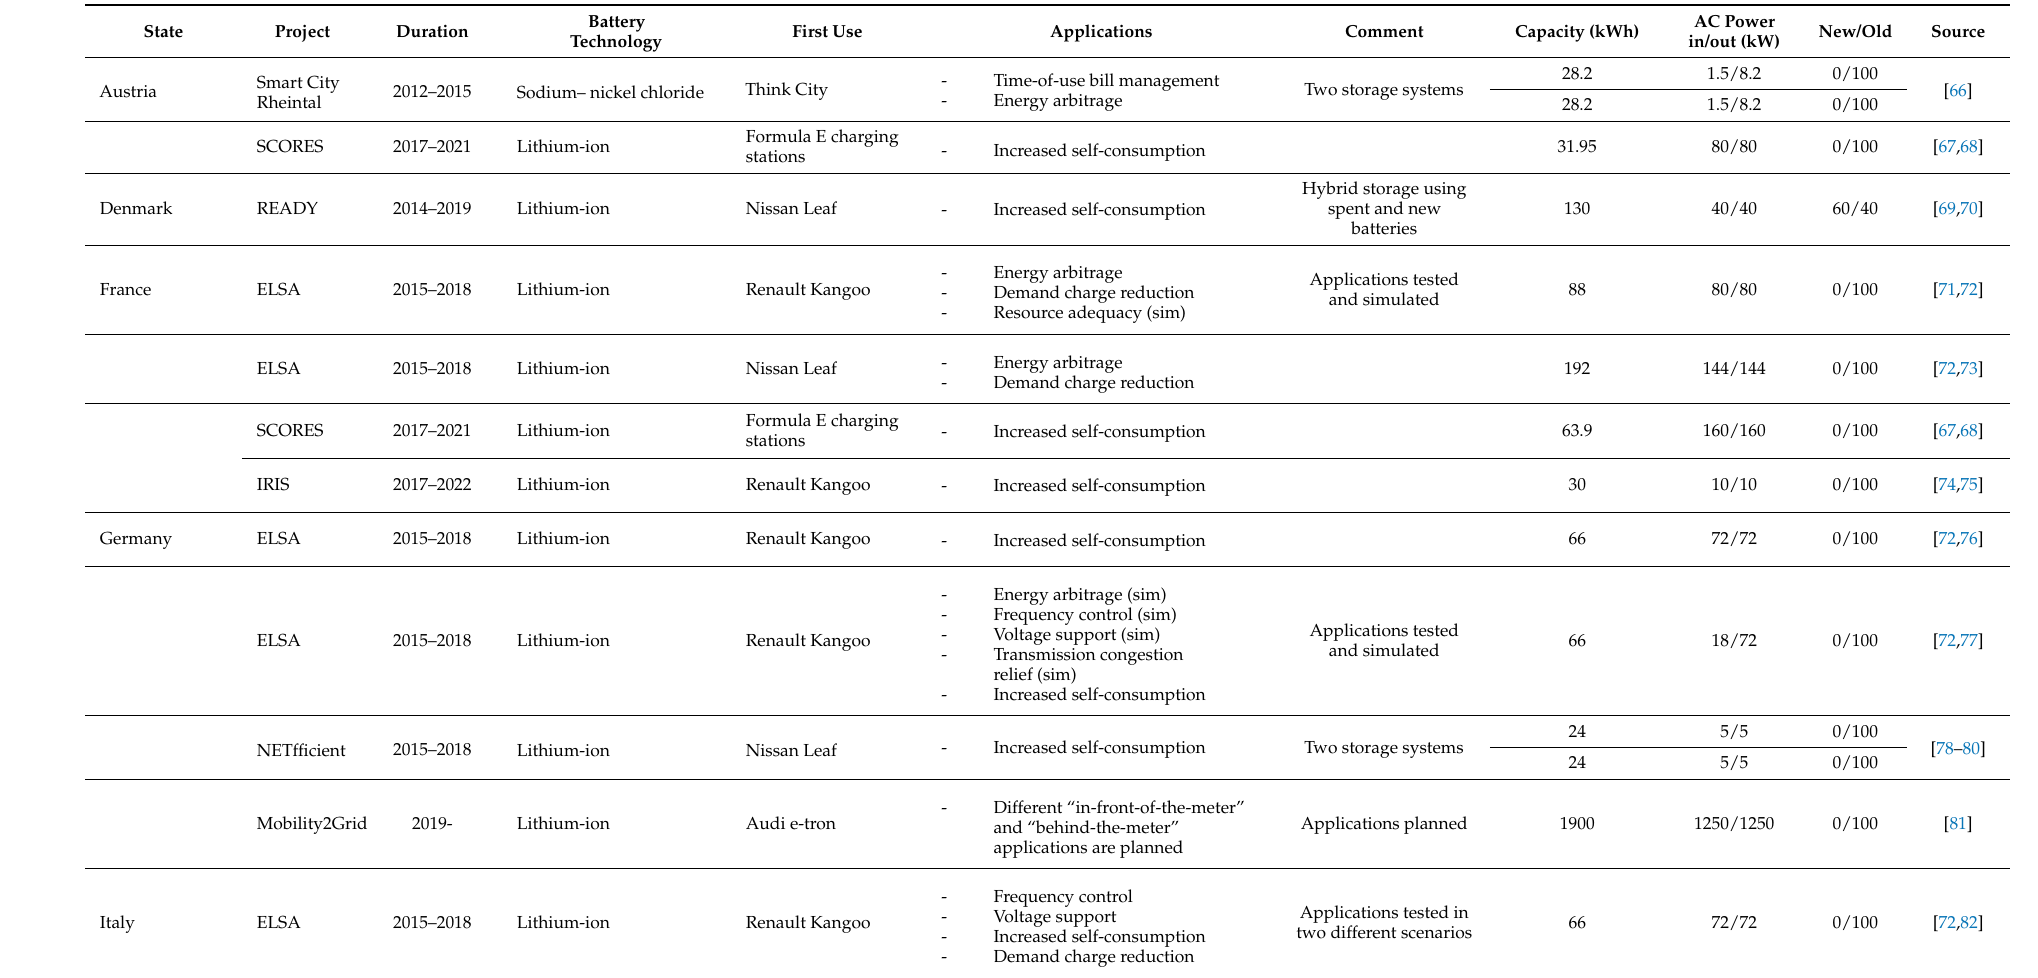
Table 2. Second use energy storage systems in Europe and their